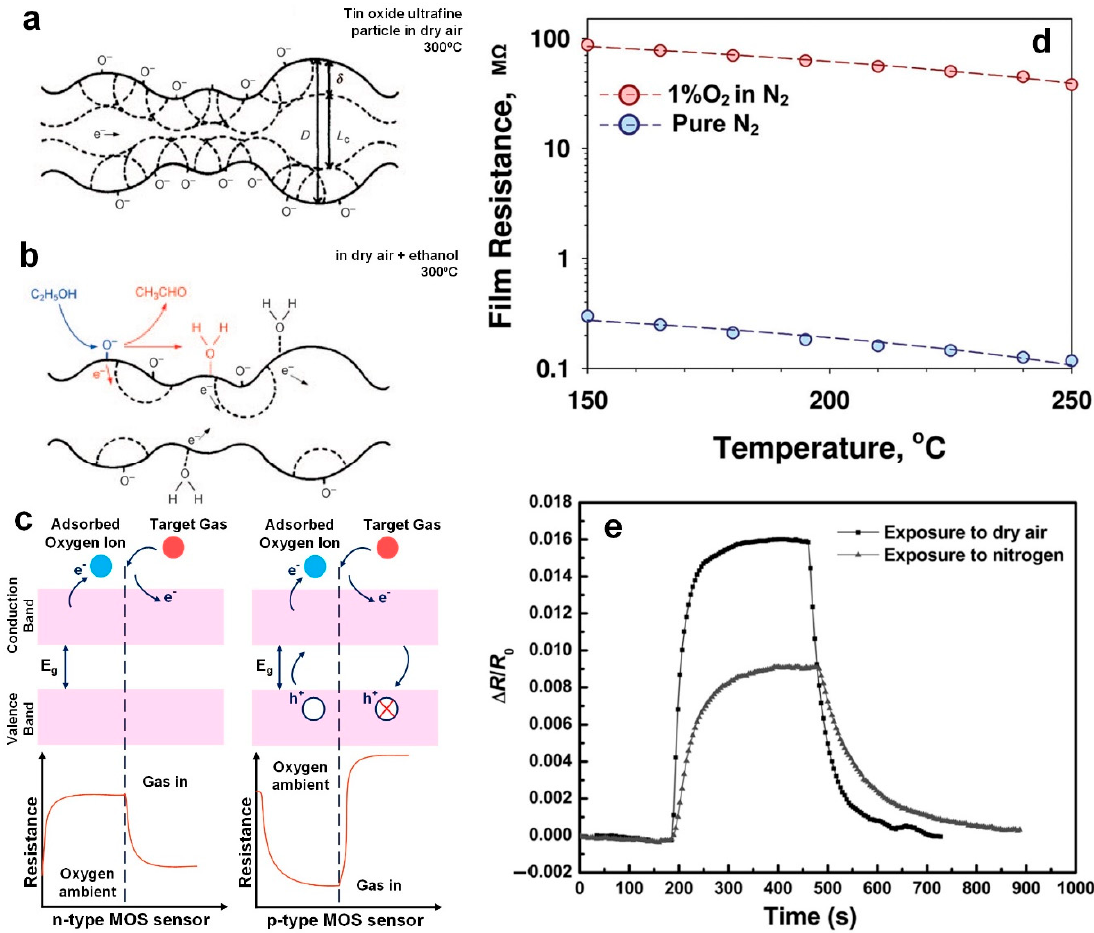
Figure 1. ( a , b ) Schematic of sensing mechanism (oxygen ions adsorption and desorption) for C 2 H 5 OH detection on the surface of tin oxide ultrafine particles in dry air and at 300 °C [1]. Reproduced with permission [1], Copyright 1982, AIP publishing. ( c ) Schematic of resistance change upon exposure to the target gas (reducing gas) for both n-type (left) and p-type (right) metal oxide